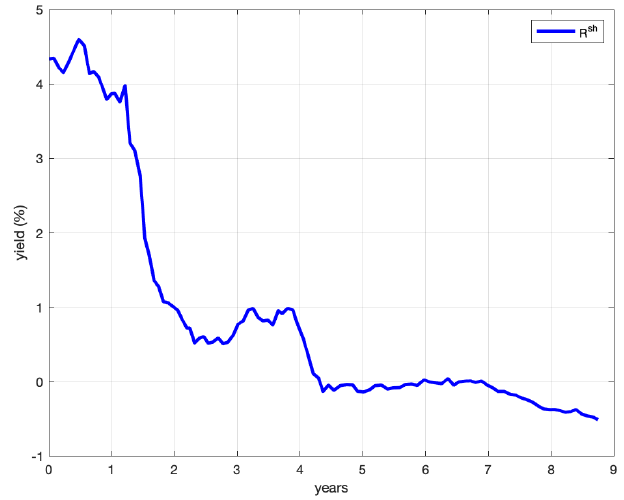
Figure 1. The filter estimated value of the short − term interest rate R sh .